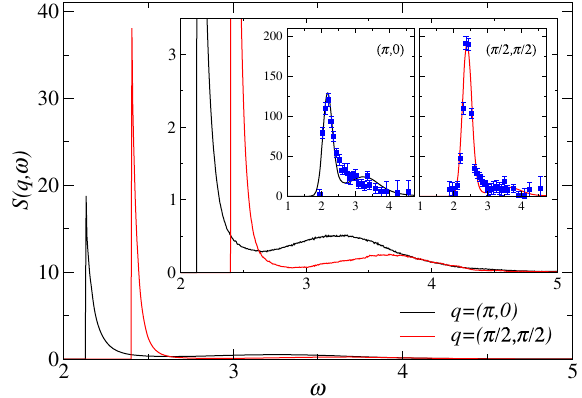
FIG. 12. Spectral functions obtained using sampling with the parametrization in Fig. 1(a) under the constraint that no weight falls below the lower bounds determined with a δ function at the 2 . 13 and 2.40 for q ¼ ð π ; 0 Þ and lower edge (Fig. 6): ω q ¼ ð π = 2 ; π = 2 Þ , respectively. The inset shows the results on a different scale to make the continua more visible. The insets of the inset show comparisons with the experimental data, where we have broadened the numerical results by Gaussian convolution and adjusted a common amplitude.